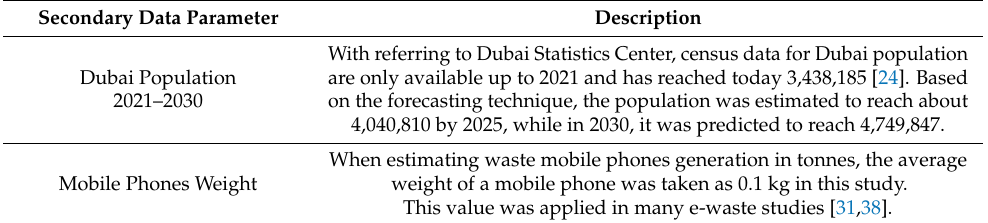
Table 4. Secondary Data